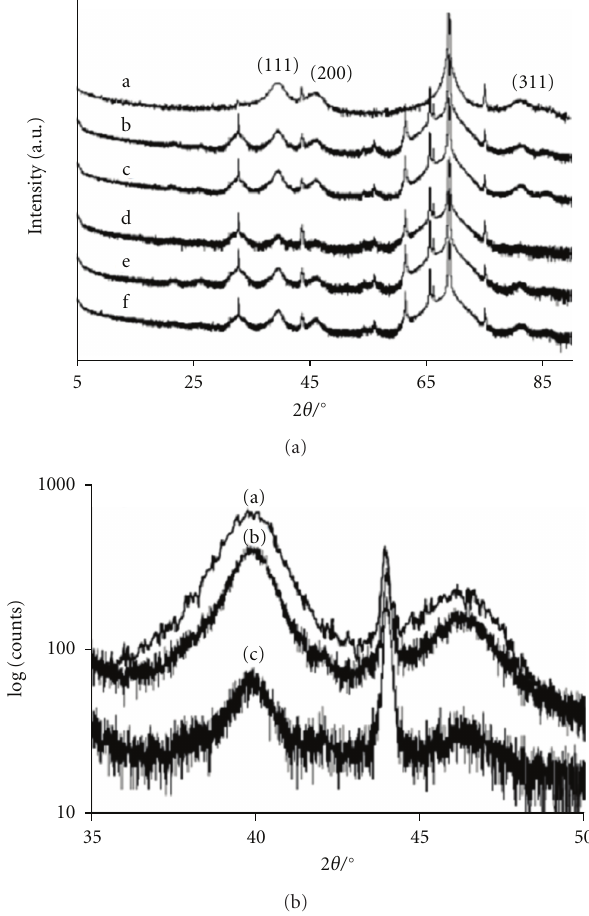
Figure 1: (a) XRD patterns of microemulsion-synthesized Pt/Sn nanoparticles deposited on BDD; (a) Pt, (b) Pt 80 Sn 20 , (c) Pt 60 Sn 40 , (d) Pt 50 Sn 50 , (e) Pt 40 Sn 60 and (f) Pt 20 Sn 80 nanoparticles. (b) XRD patterns of microemulsion-synthesized Pt (a), Pt 80 Sn 20 (b) and Pt 50 Sn 50 (c) nanoparticles deposited on BDD in the Pt(111) and Pt(200) reflections region (Reprinted with permission from